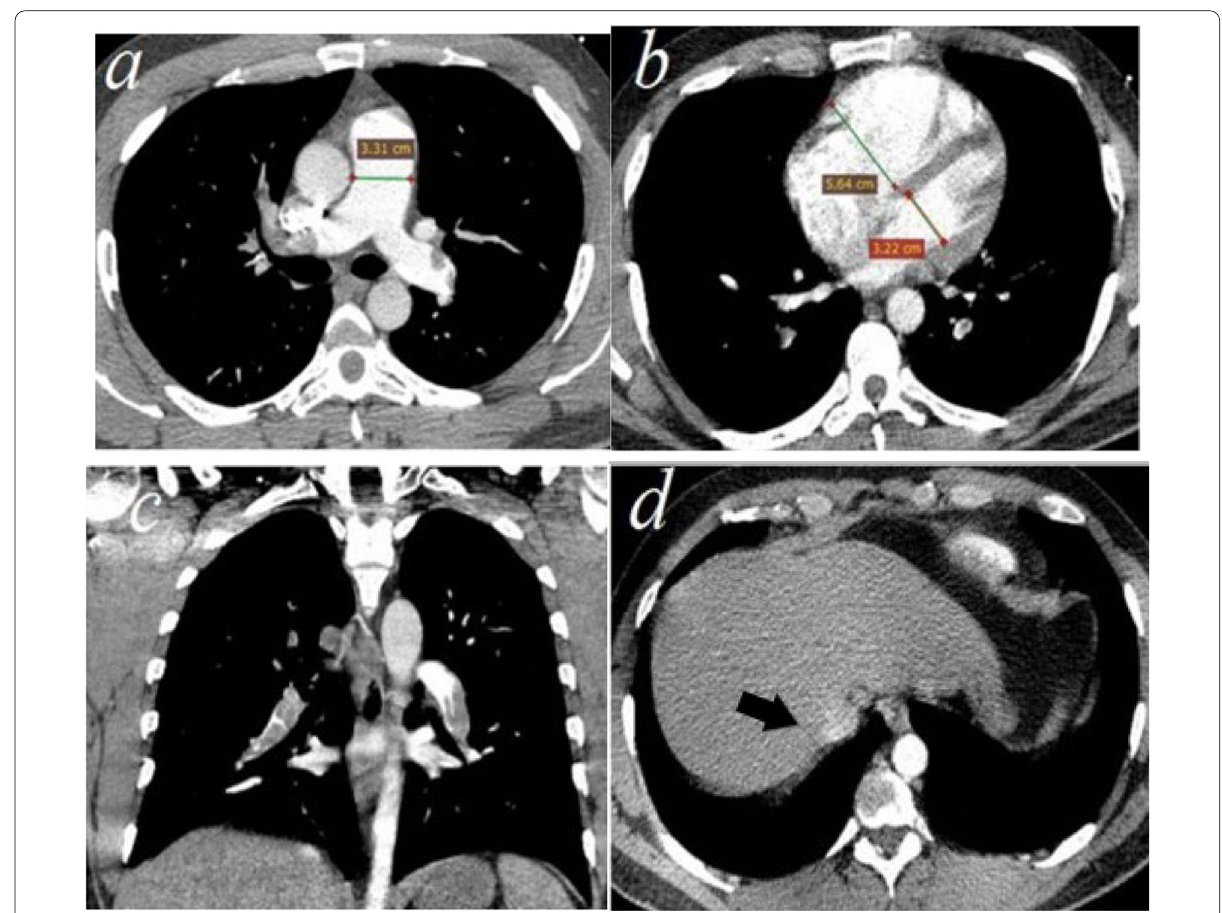
lobe and lower lobe divisions bilaterally. b Axial cuts showing dilated PA measuring about 33 mm in diameter, RV/LV ratio > 1 with associated septal deviation. c Coronal cuts showing Extensive pulmonary emboli extending to lower lobe divisions bilaterally. d Axial cuts showing no